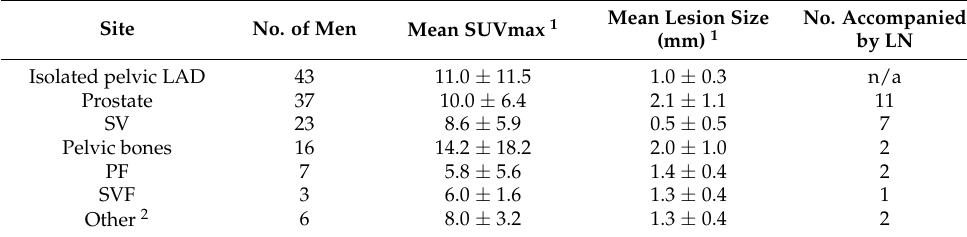
Table 2. 68Ga-PSMA PET/CT positive findings.